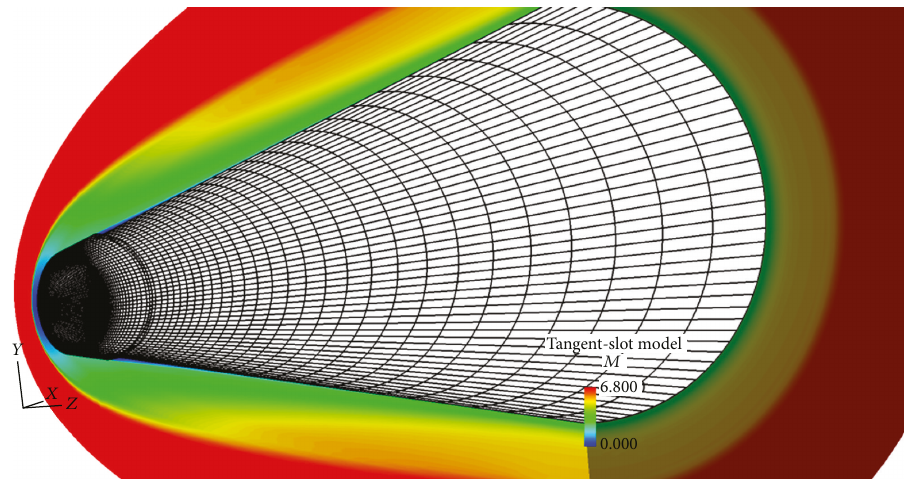
Figure 20: Tangent-slot model, no jet fl ow in the slot, Re = 4 3 × 10 6 , α = 0 0 ° , M = 6 8